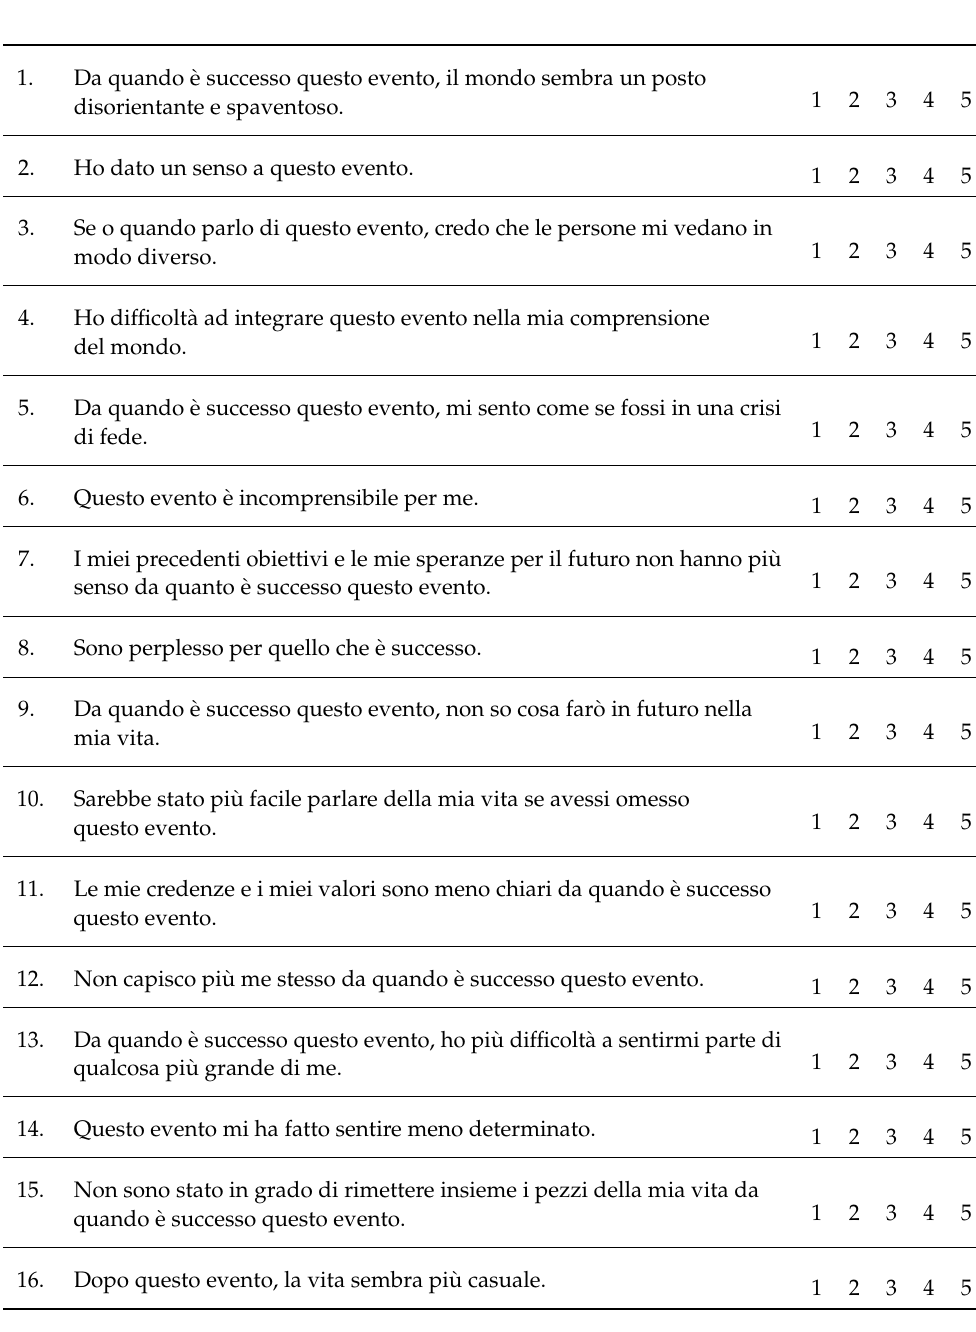
Da quando è successo questo evento, ho pi ù difficolt à a sentirmi parte di qualcosa pi ù grande di me. Questo evento mi ha fatto sentire meno determinato.